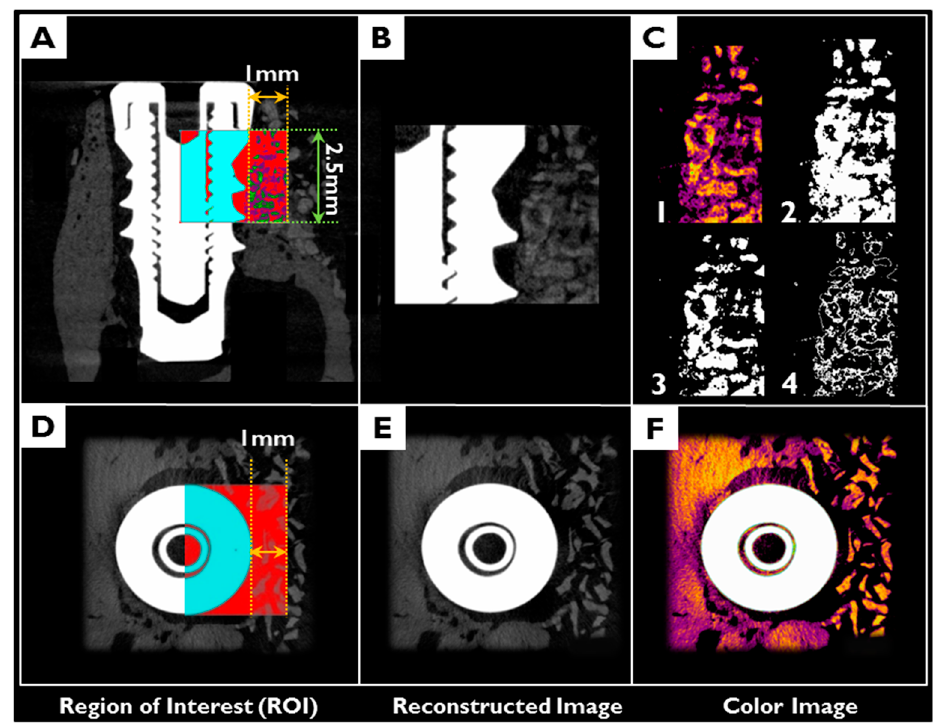
Figure 14. 3D reconstructed μ CT images of a region of interest (ROI: 1 mm wide and 2.5 mm high from the implant platform): ( A – C ) cross sectional view; ( D – F ) occlusal view; ( C1 , 2 ) images of total bone including bone graft materials ( C3 ); and new bone ( C4 ).